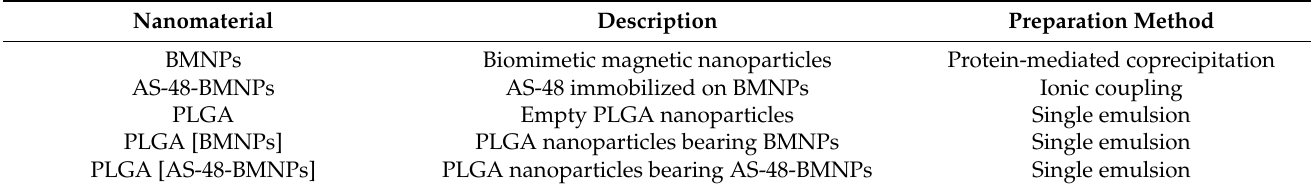
Table 1. Summary of the nano-formulations prepared and analyzed in the present